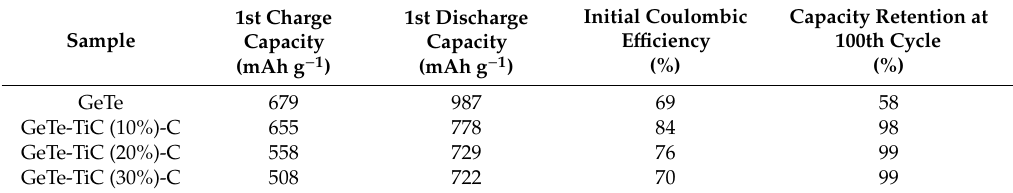
Table 1. Electrochemical properties of GeTe and GeTe-TiC-C electrodes.